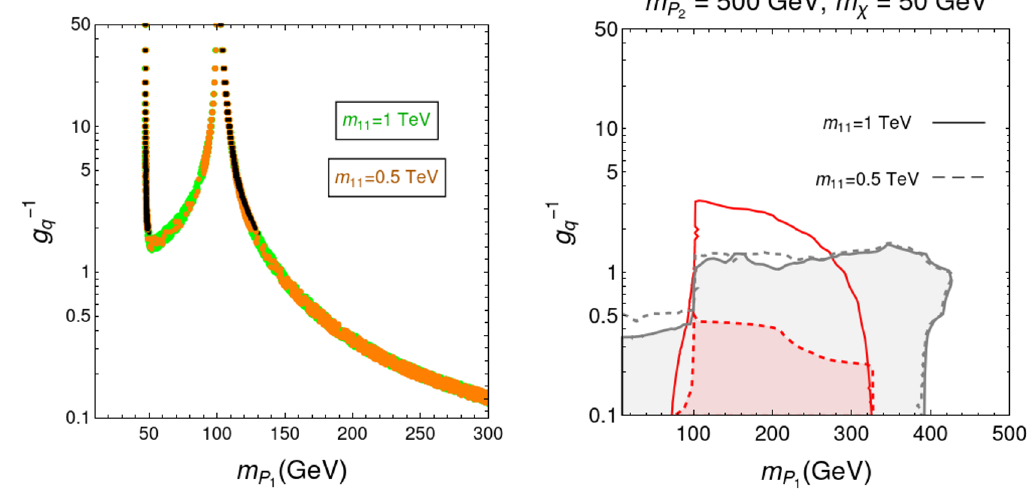
Figure 8 . Cosmology (left) and LHC (right) constraints on the model for two representative values of m , taken to be 1 GeV and 1 TeV. We make use of the same colour code as in figure 11